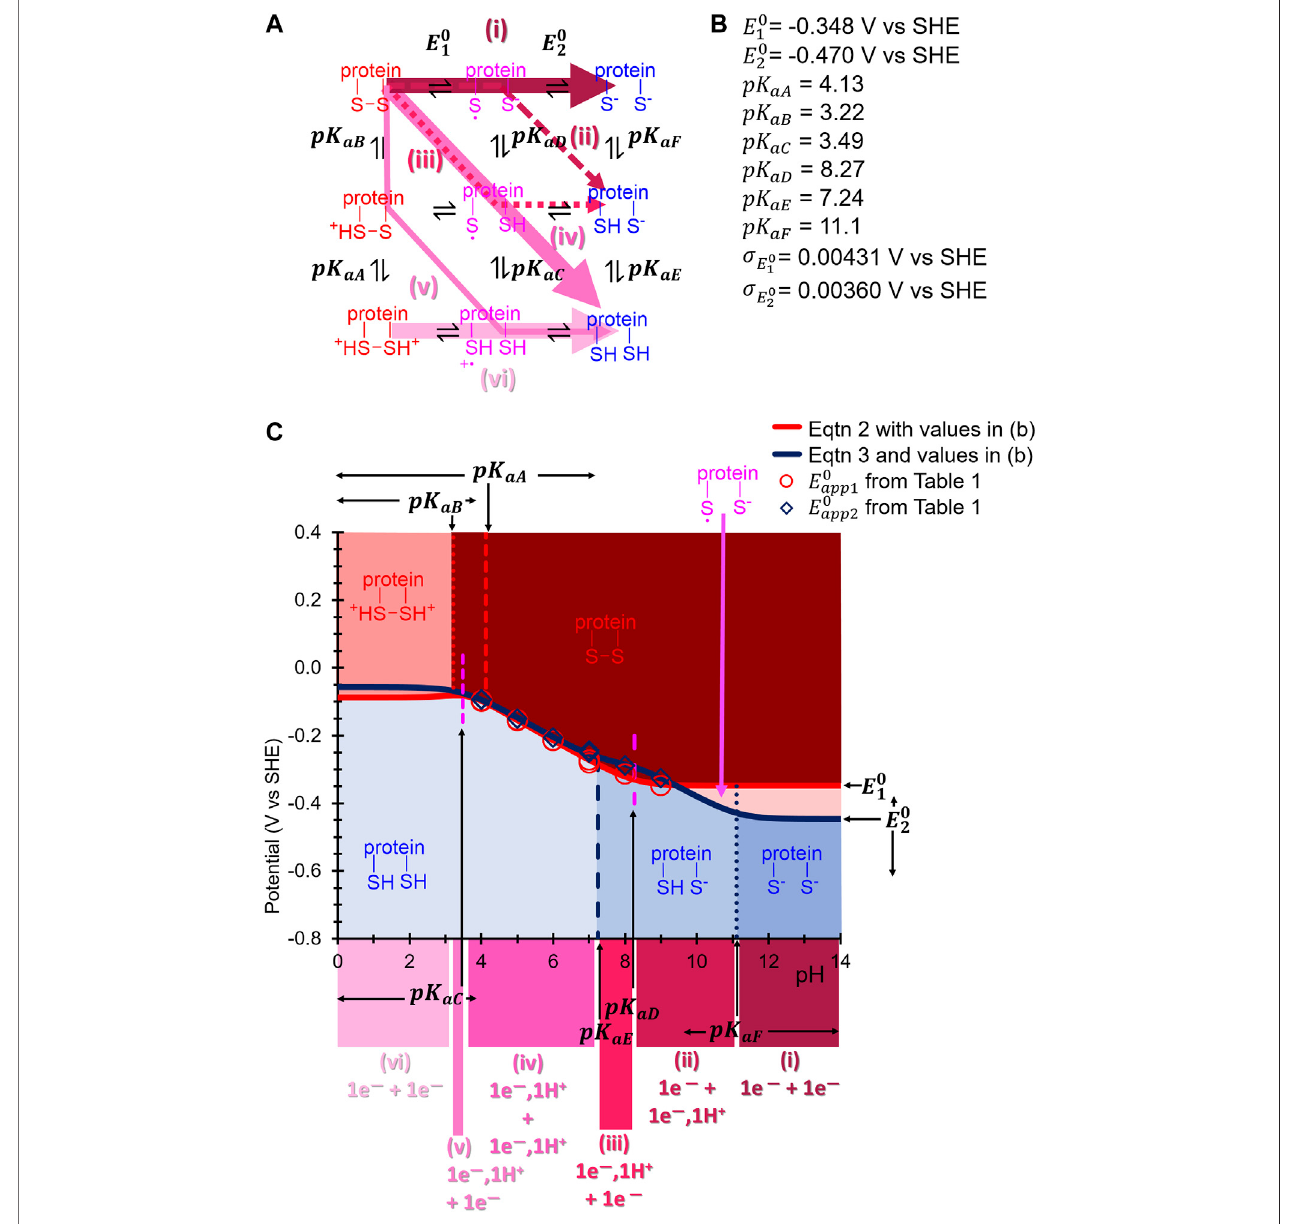
FIGURE 7 | (A) Square scheme from Figure 1B updated to show the appropriate pKa and E 0 symbols associated with each protonation and electron-transfer reaction, respectively, of H2ase-MFHypD. Coloured arrows indicate the suggested reaction path taken through the scheme at different pH values. (B) Best fi t inferred pK a and E 0 1 , E 0 2 (potentialvaluesatthemostalkalinepH)arecalculatedasdescribedinthetext. (C) E 0 app 1 and E 0 app 2 vs.pHdatafrom Table1 plottedalongwithpredicted E 0 1 , E 0 2 and pK a valuesshownin (B) .Thepredictedproteinstateisindicatedbybackgroundcolourandassociatedlabelwithintheareaoftheplot,andthepredicted square scheme path is indicated by regions of colour underneath the x -axis which correspond to the arrow colours in (A) . The MCMC calculated parameter distribution range is shown about each parameter name in (C) where the distribution is wide enough to allow it to be shown in this manner.